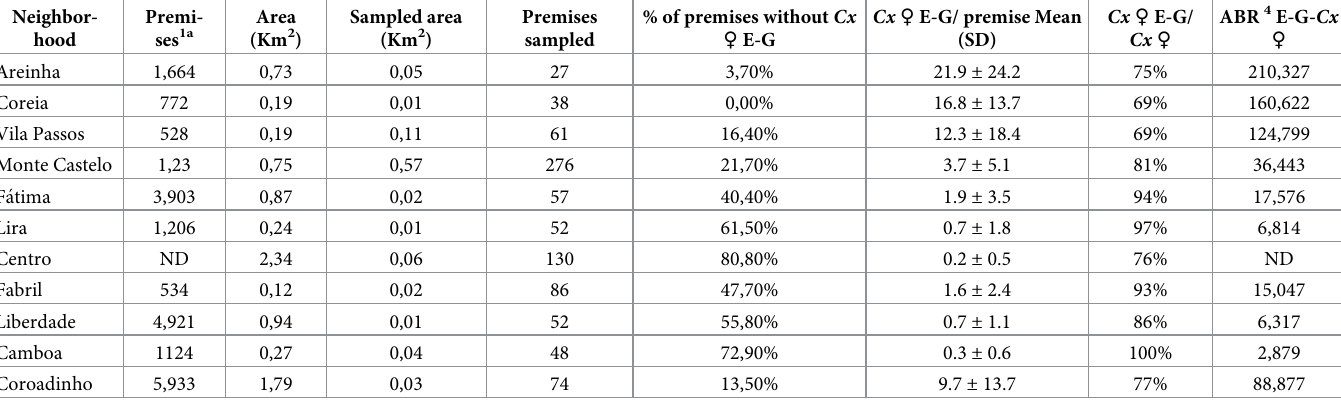
Table 3. Socioeconomic indicators and Culex quinquefasciatus ♀ collected in the entomological survey areas for the investigation of LF status in S ã o Luı´s, MA, Brazil. Neighbor-